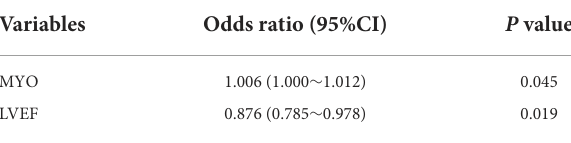
TABLE 4 Binary logistic regression analysis of predictors of in-hospital mortality in children with FM.